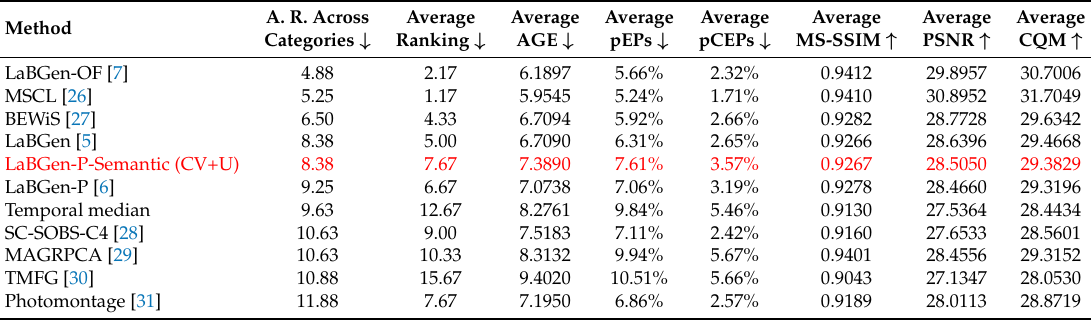
Table 4. Top 10 reported on the SBMnet website 6 May 2018 in which the performance achieved